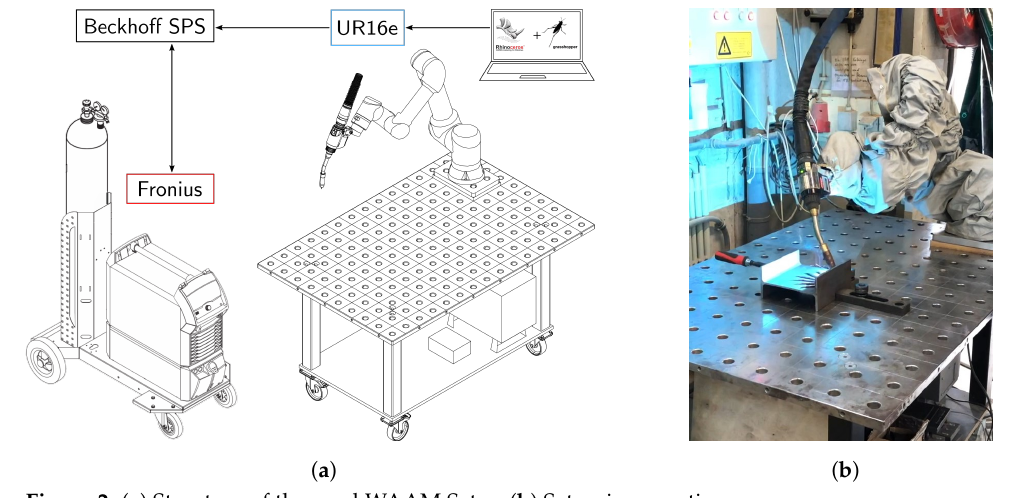
Figure 2. ( a ) Structure of the used WAAM Setup ( b ) Setup in